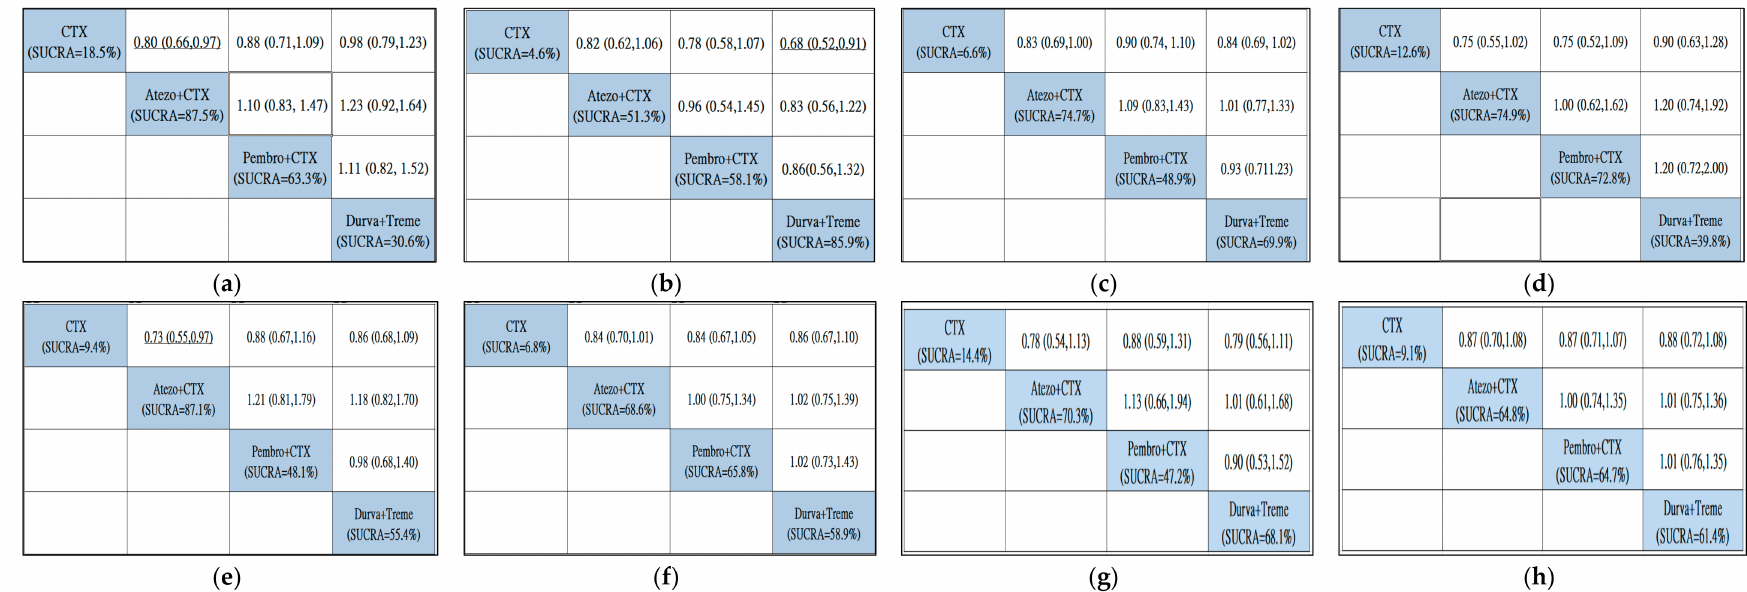
Figure A3. Subgroup analysis in OS by age, gender, cisplatin eligibility, and primary tumor site. ( a ) For age ≥ 65; ( b ) for age < 65; ( c ) for male; ( d ) for female; ( e ) for cisplatin eligibility; ( f ) for cisplatin ineligibility; ( g ) for primary tumor location in the upper tract; ( h ) for primary tumor location in the lower